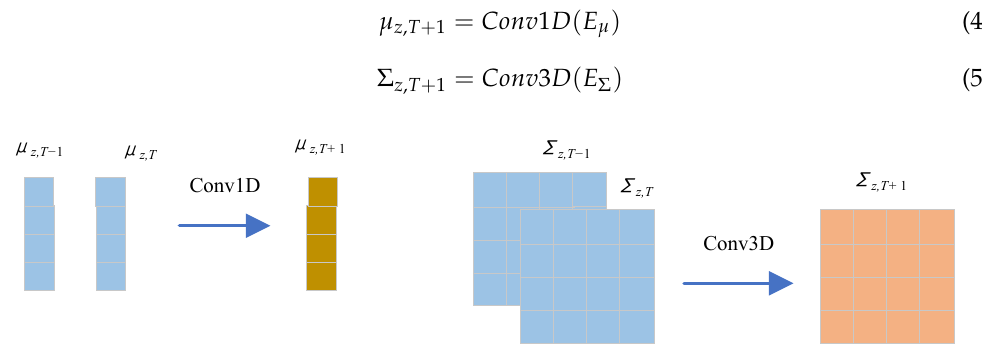
Figure 3. State causal convolution. The mean and covariance matrix of z T + 1 are estimated using 1D and 3D convolutions,